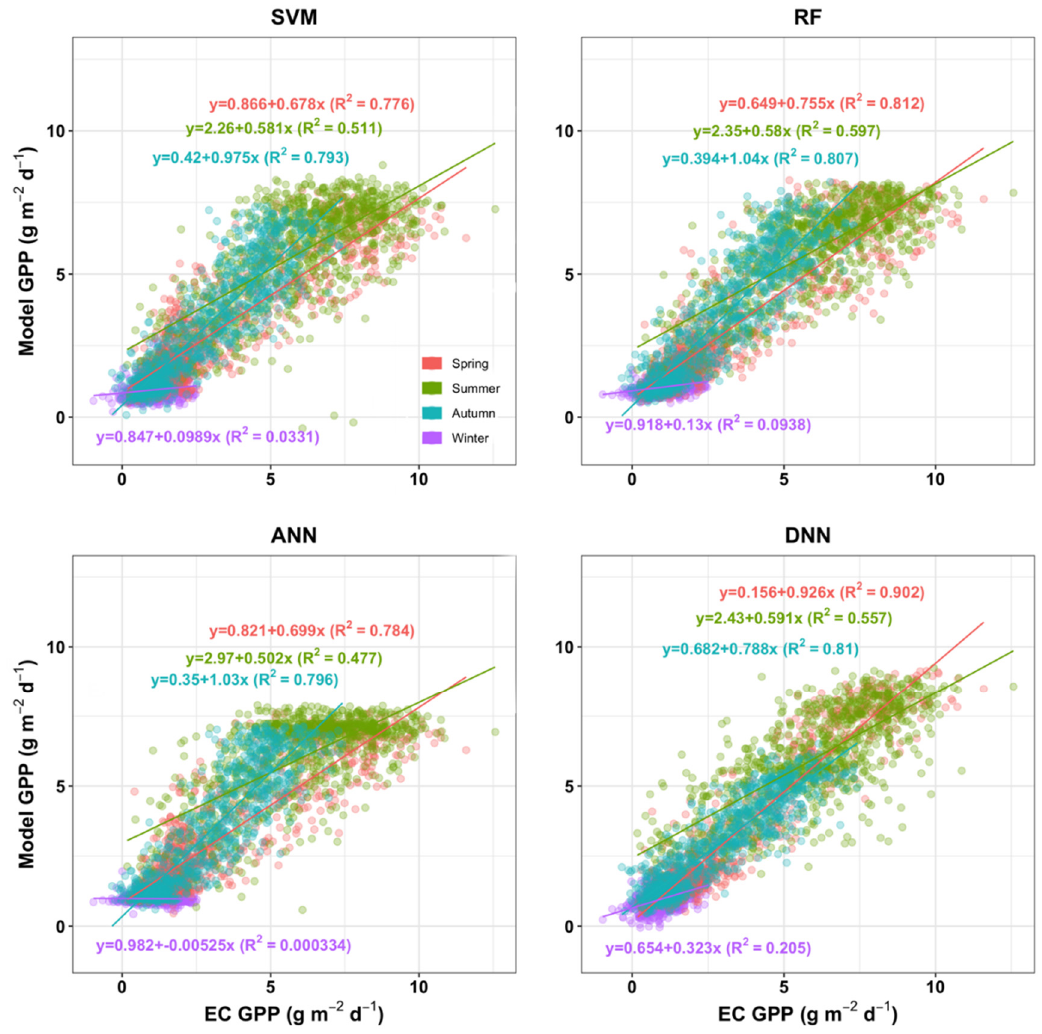
Figure 9. Comparisons between artificial intelligence (AI) models for observed vs. predicted gross primary productivity (GPP) by season.